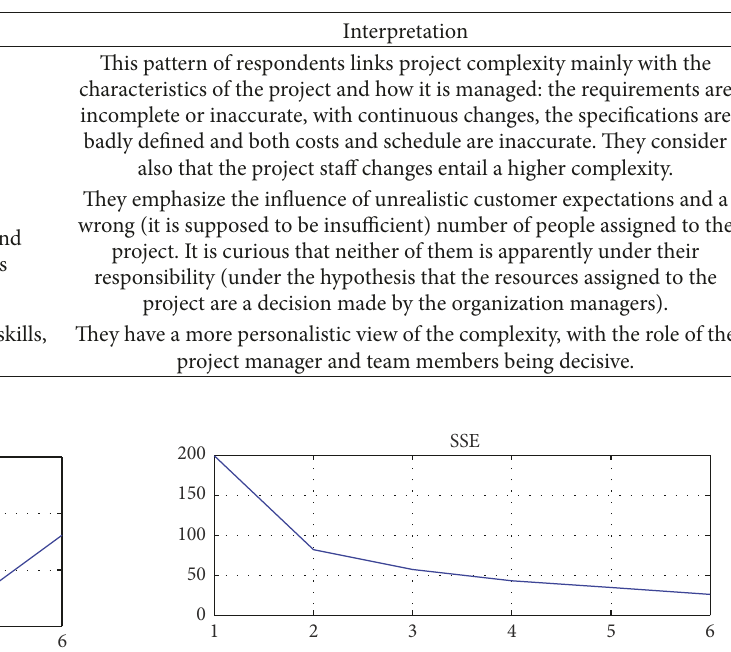
Table 8: Summary of patterns interpretation.